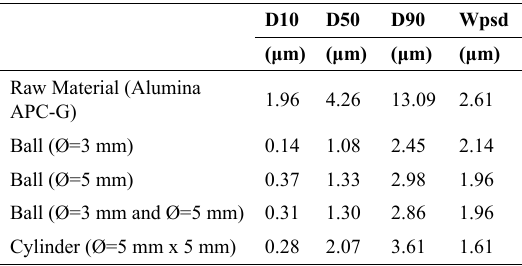
Figure 3. Particle size distribution: effect of media size and shape. Table 1. Particle size distribution